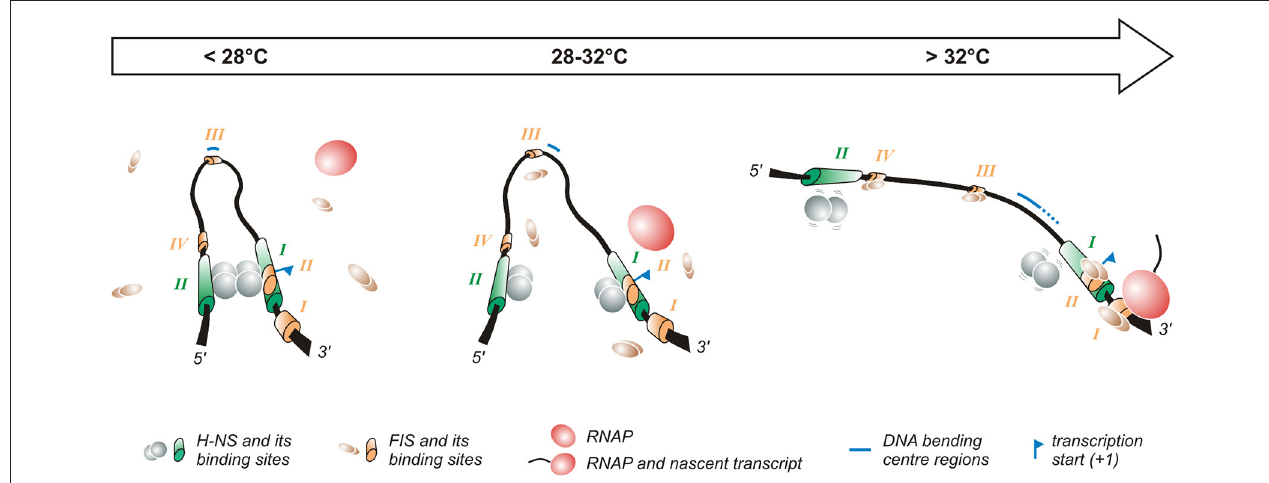
FIGURE 2 | Temperature-dependent regulation of the promoter of the virF gene. The virF promoter contains two H-NS (indicated in green) and four FIS (indicated in orange) binding sites (Falconi et al., 1998, 2001). The arrow on the top of the figure indicates the transition from the outer environment (colder) to the intestinal host milieu (warmer). Left panel : At lower temperature a compact structure exists where H-NS represses virF by interacting with H-NS binding sites I and II which are separated by a DNA region whose sequence-mediated curvature is favored by the lower temperature. Middle panel : The intrinsic bend located between the two H-NS binding sites melts abruptly around 32 ◦ C and the bending center slides downstream unmasking a binding site for FIS. Right panel : By increasing the temperature the DNA bend relaxes further, H-NS interactions to binding sites I and II weaken and FIS gains easier access to its binding boxes, thus counteracting H-NS repression. Altogether these events lead to the formation of an active transcription